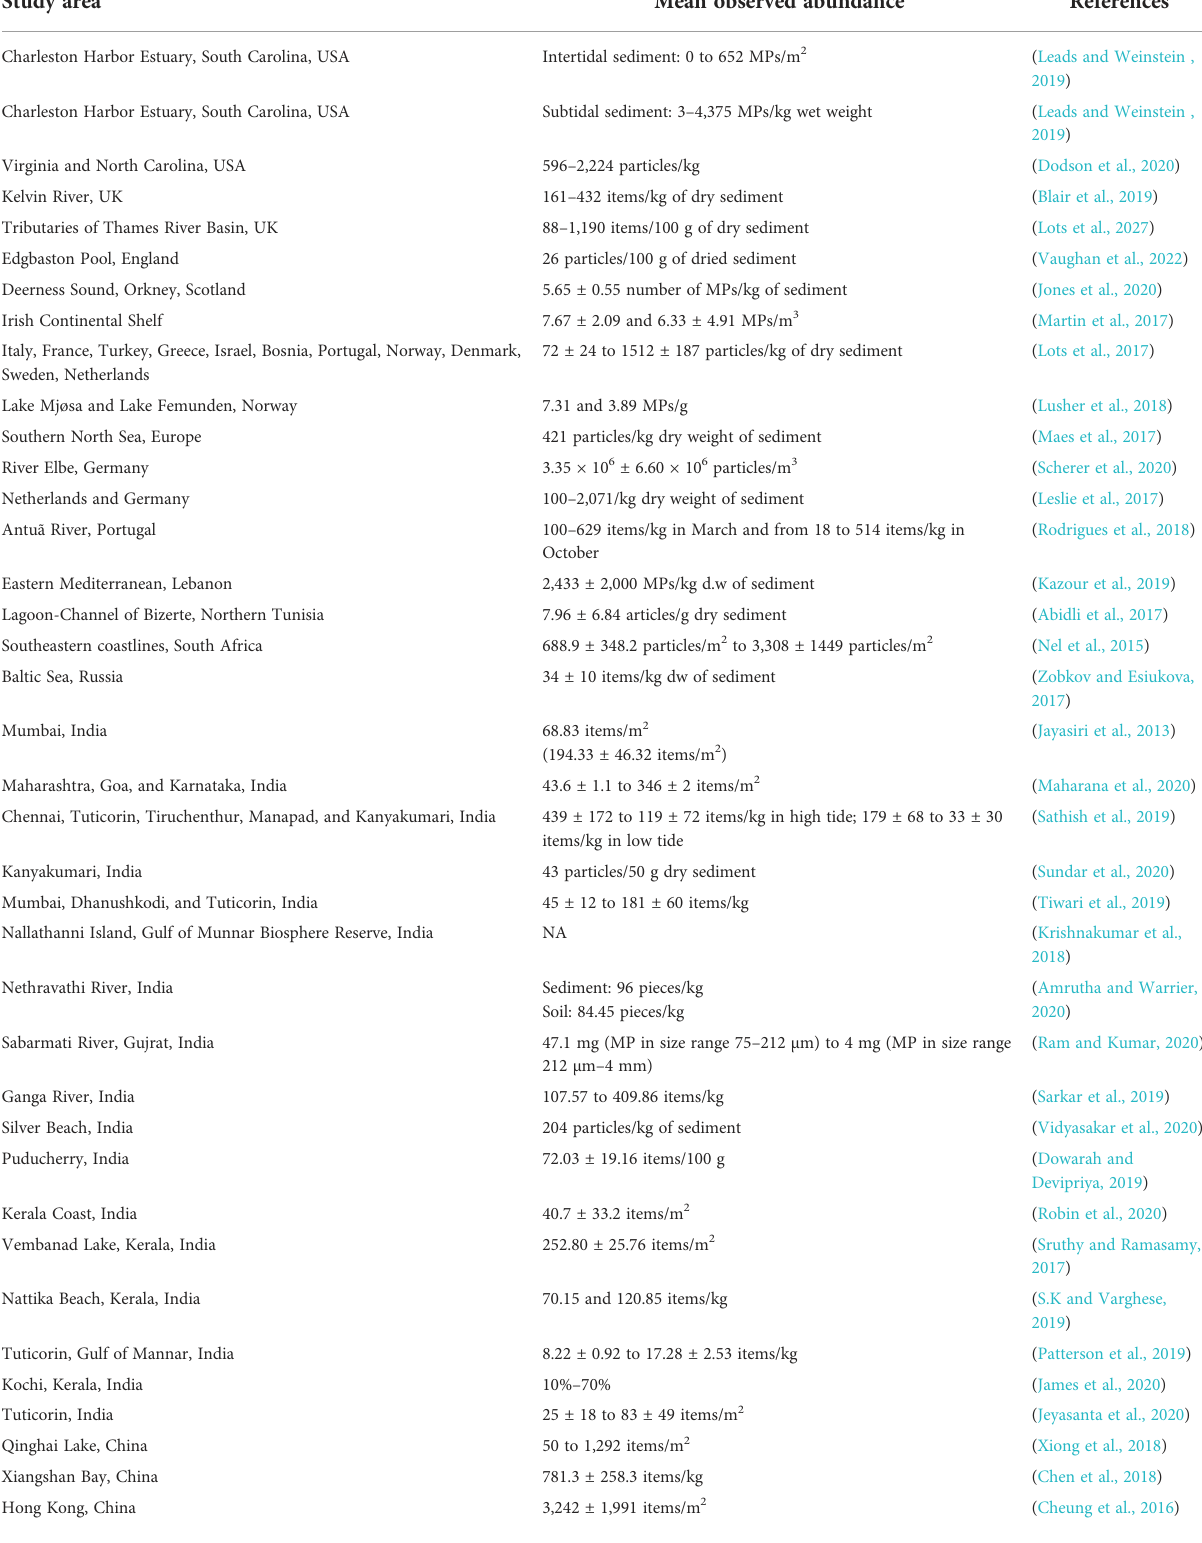
TABLE 1 Studies on MP abundance in sediments summarized from selection of reports across the